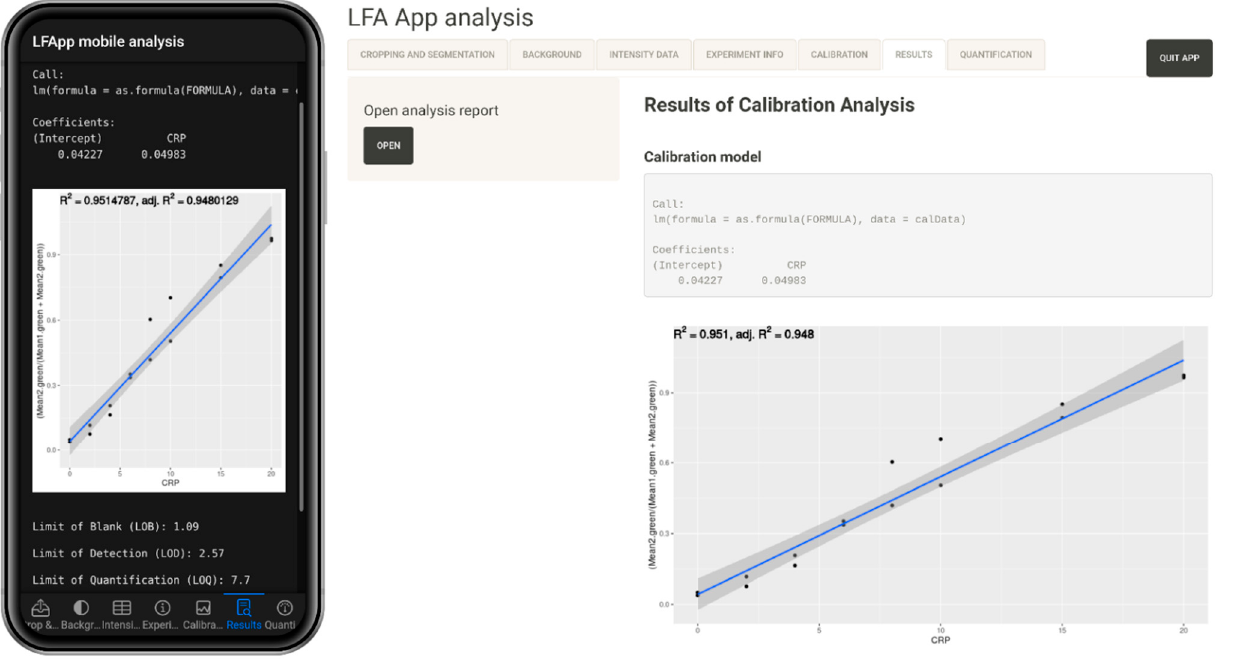
Figure 4. Results of the calibration analysis with LFA App mobile analysis ( left ) and LFA App anal- ysis ( right ). analysis ( right